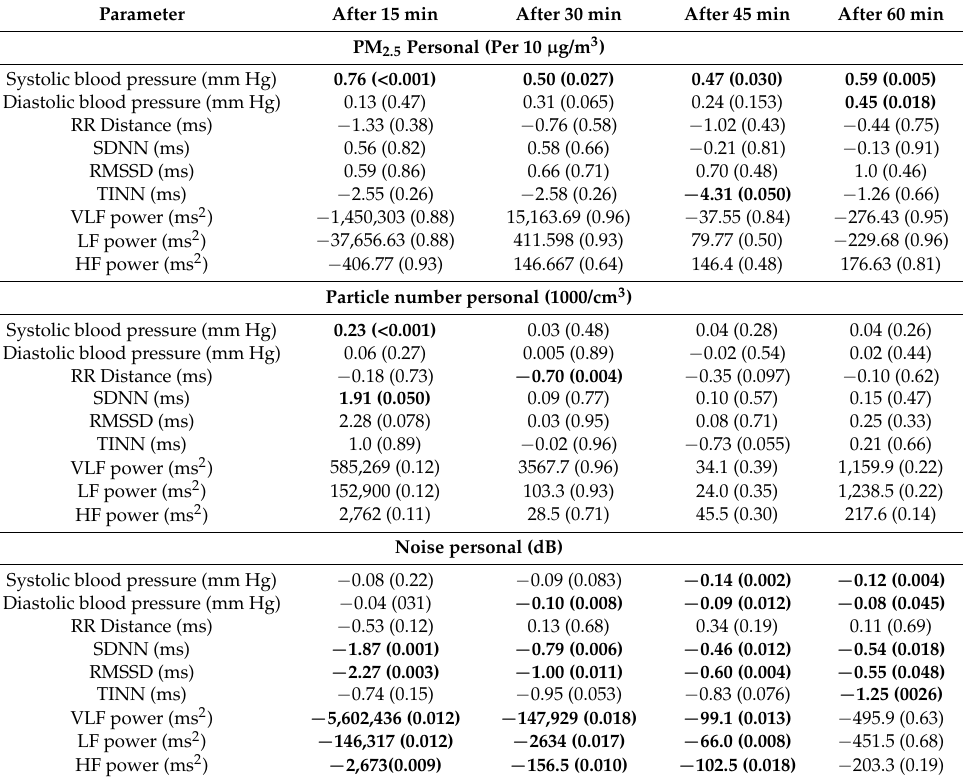
Table A2. Unadjusted effect estimates ( p -value): change in cardiovascular parameters per 1 µ g/m 3 (personal PM 2.5 ), per 1000 particles per cm 3 , and per dB. ( bold: p < 0.05 ).